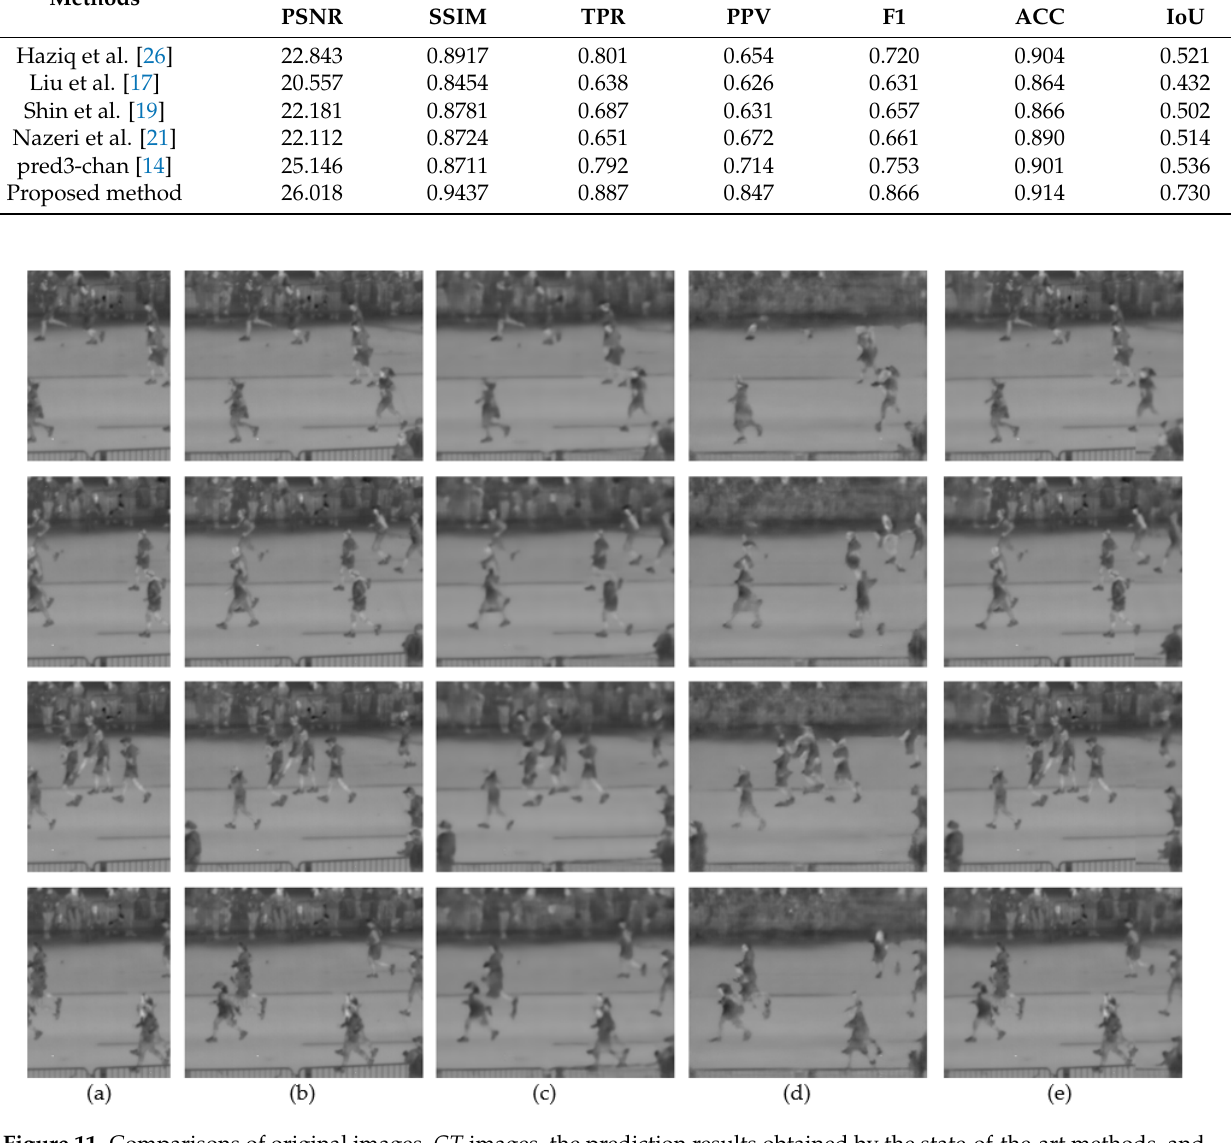
Figure 11. Comparisons of original images, GT images, the prediction results obtained by the state-of-the-art methods, and the proposed method: ( a ) original images, ( b ) GT images, and images predicted by ( c ) Haziq et al. [26], ( d ) Liu et al. [17], and ( e ) the proposed method.